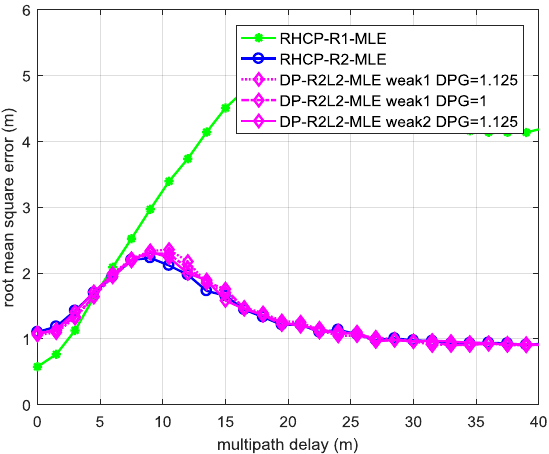
Figure 3. The RMSE of the TOA estimation of the LOS signal using MLE with different models in the two-path environments defined by Weak LHCP Signal Cases 1 and 2 in Table 2.